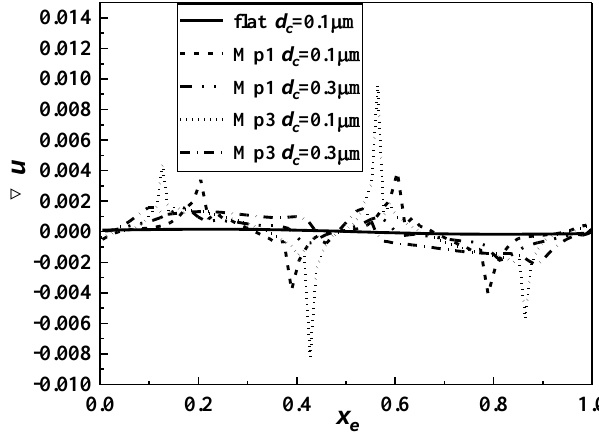
Figure 8. Velocity gradient distribution.